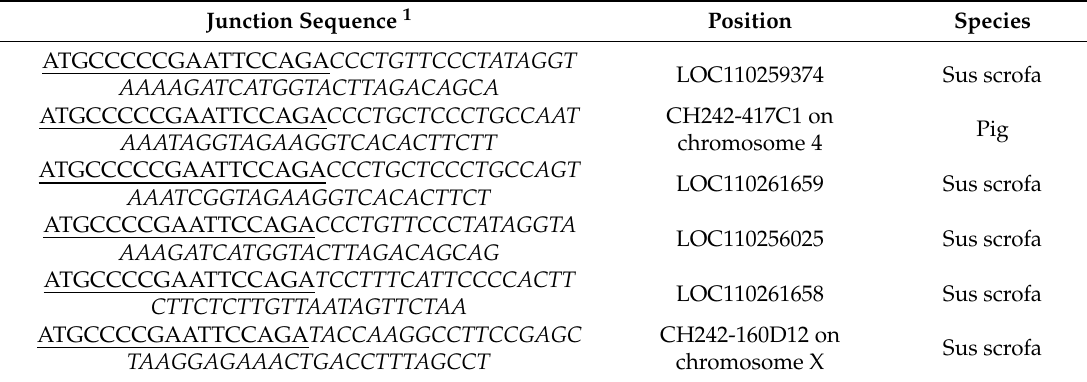
Table 3. Identification of PERV insertion of NHP’s bladder using inverse PCR.